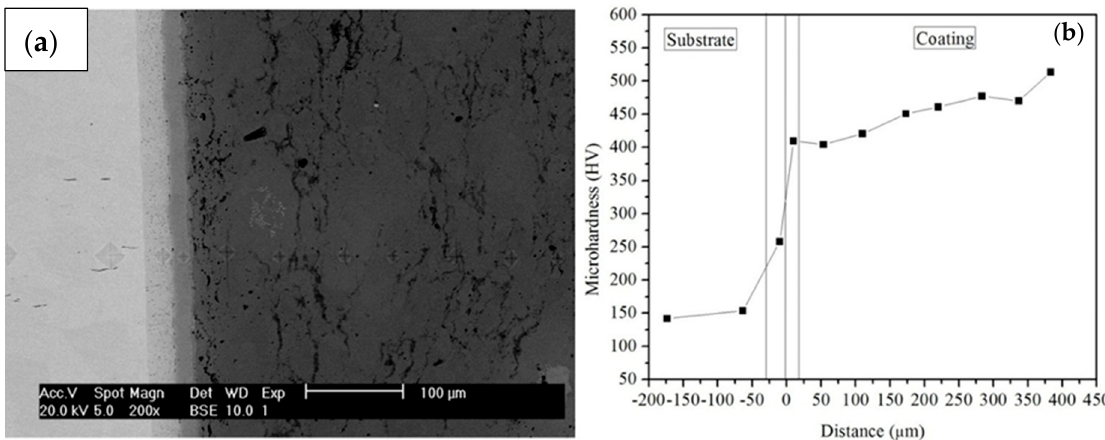
Figure 9. ( a ) SEM image of a cross-section of the sample processed at 850 °C and 15 MPa for 7200 s, and ( b ) microhardness measured at the different layers of the sample.